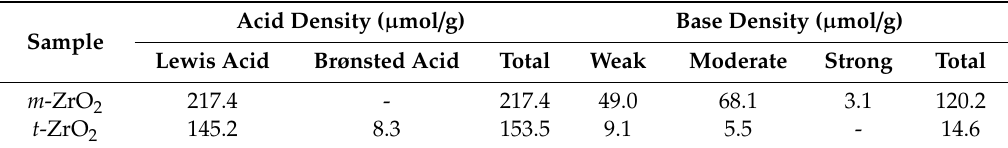
Table 2. Acid and base density of the catalysts characterized by the NMR technics [31]. Acid Density ( µ mol / g) Sample